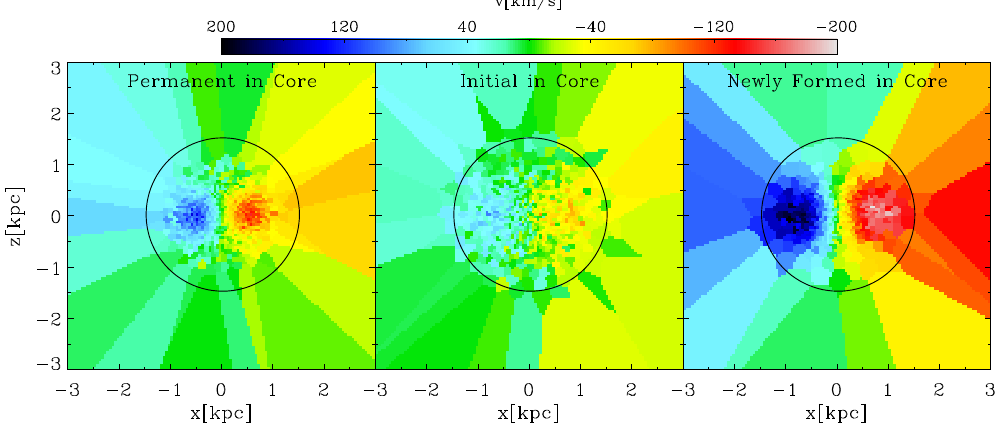
Figure 4. LOSVD maps of the central 3 kpc in the x – z projection. Left panel : all permanent core stars; central panel : permanent core stars that are initially in one of the progenitors; right panel : permanent core stars that are formed in situ during the simulation. The panels share a common velocity scaling given in the color bar. The solid black circle indicates the core radius of r CORE = 1.5